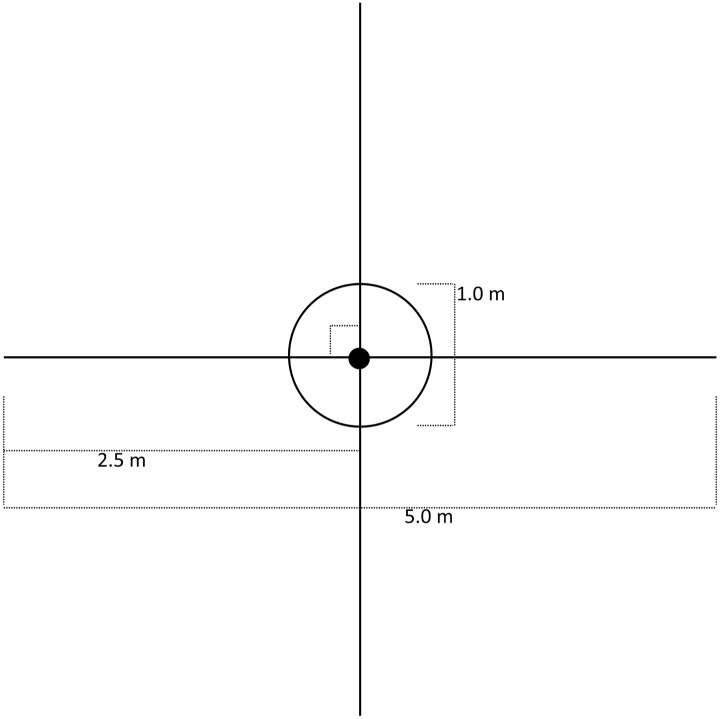
Diagram of plot and transect design used to measure habitat variables.One 1-m-diameter plot and four randomly-oriented perpendicular 2.5-m transects placed with the snake/random location as the centerpoint.